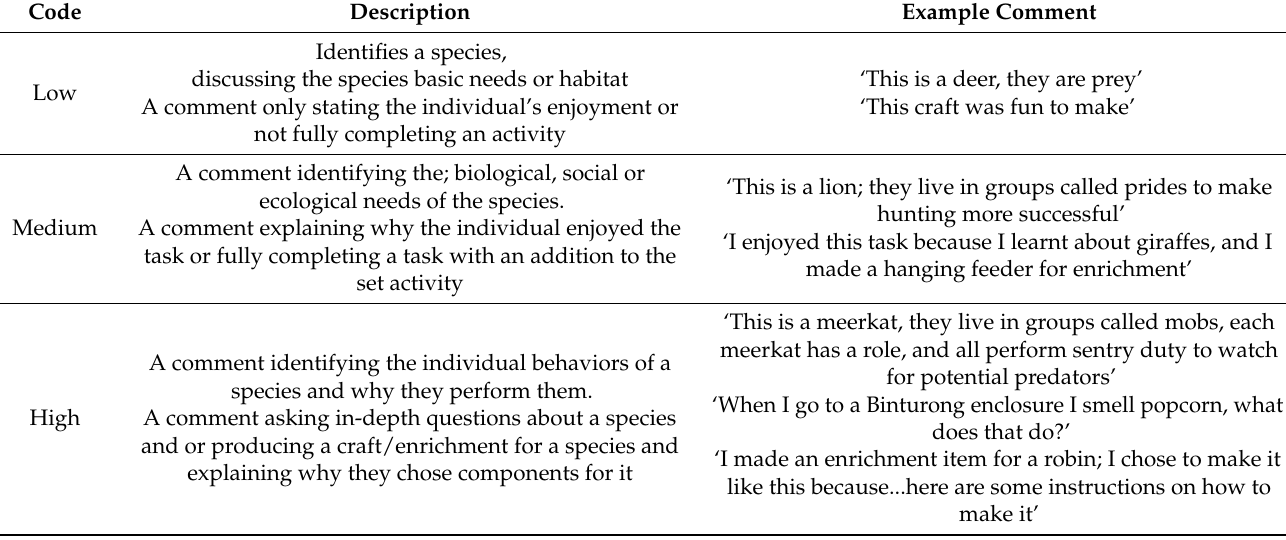
Table 2. Coding for levels of submissions from prescribed